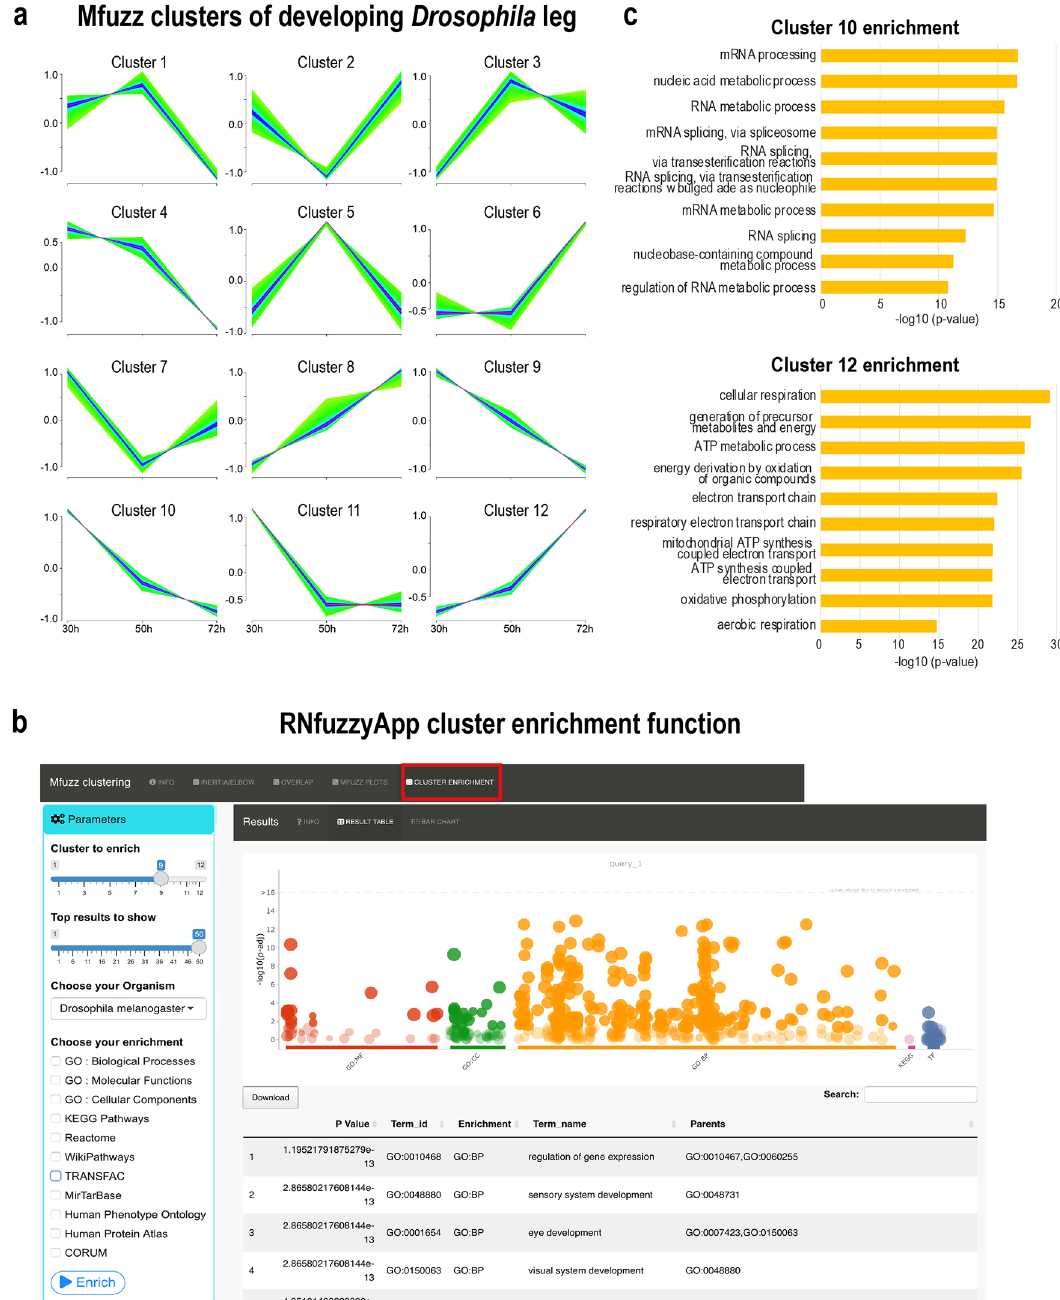
Figure 6. Mfuzz soft clustering analysis. (a) Mfuzz clusters of Drosophila leg developmental RNA-seq data. Some similar patterns emerged, with expression profiles peaks early (30 h), mid-phase (50 h) or late (72 h APF (after puparium formation)). (b) Mfuzz clusters have been enriched using gprofiler2. In the parameters box, settings have to be chosen, such as the cluster number submitted for enrichment, the number of results to show, the organism, as well as the databases used for enrichment analysis. The plot on the right-hand side shows the enrichment of cluster 9. (c) Enrichment of the top 10 processes from cluster 10 and cluster 12. In cluster 10, processes related to RNA metabolism, as well as splicing are enriched, associated genes show a decrease in expression over time. In cluster 12, processes related to mitochondrial energy metabolism are enriched, with associated genes showing an increase in expression over